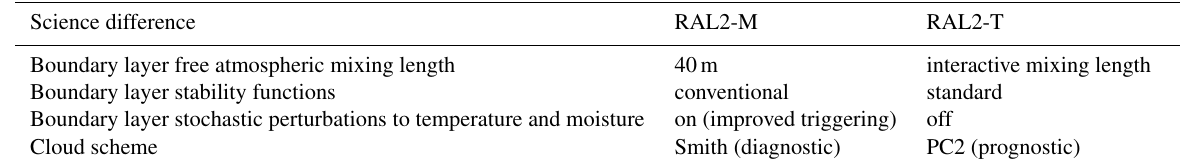
Table 2. RAL2-M and RAL2-T differences.